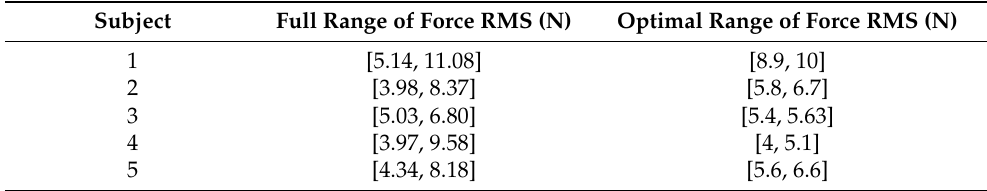
Table 4. The full range of force RMS measured by the WPAS for each subject and the corresponding optimal ranges